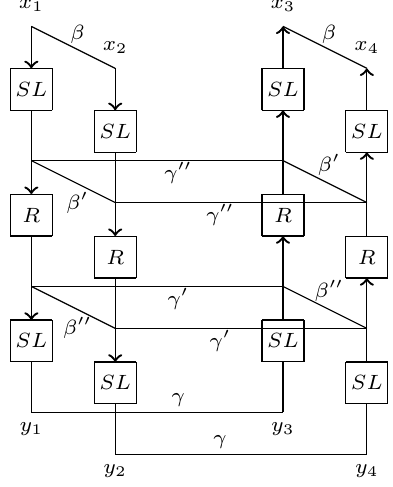
Figure 6: A 2-round E m which consists of two S-box layers and one linear